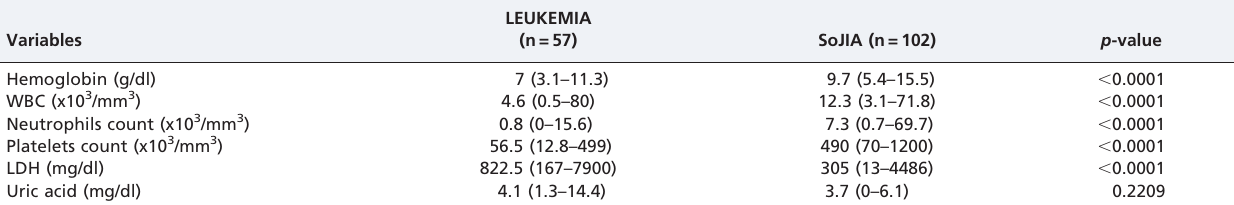
Table 2 - Initial laboratory alterations in acute lymphoblastic leukemia patients vs. systemic-onset juvenile idiopathic arthritis